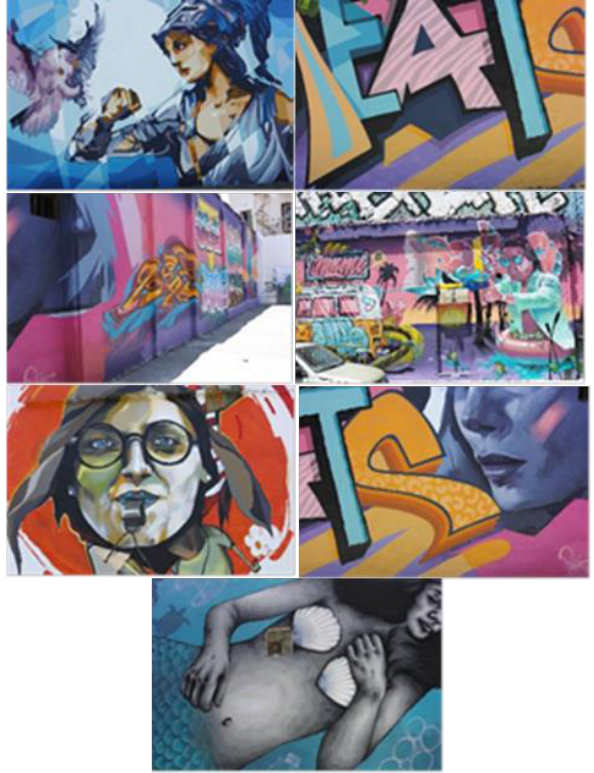
Figure 1: Array of images containing I(ref)s used for the testing (From left to right, top to bottom): Athena, aZoomed, pinkGraf, Miami, redWhistle, sLips,